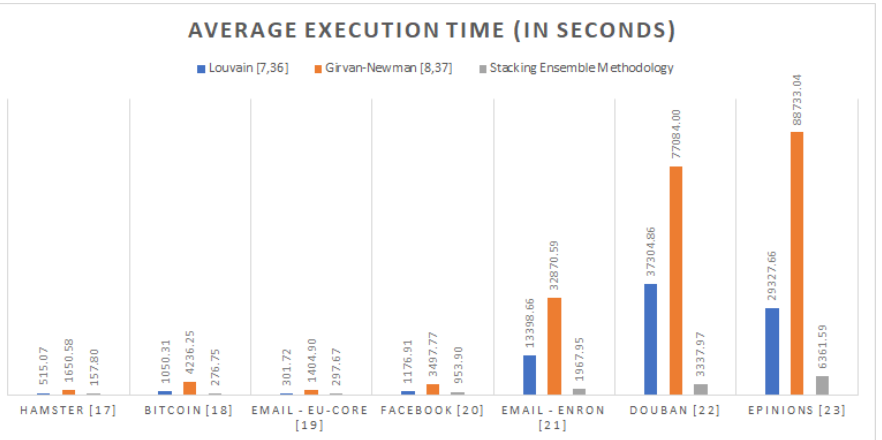
Figure 5. The average execution time of the proposed community prediction methodology and the classic community detection algorithms per distinct social graph in seconds.